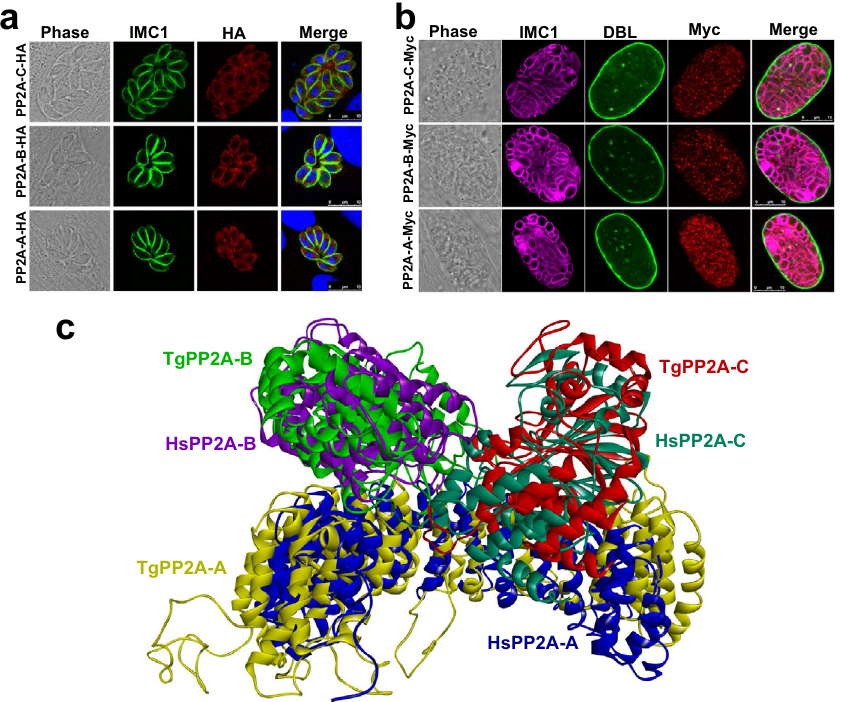
Fig. 1 | Characterization of PP2A holoenzyme of Toxoplasma gondii . a Indirect immuno fl uorescence of T. gondii RH tachyzoites expressing PP2A-C-6HA, PP2A-B- 6HAandPP2A-A-6HAunderthecontroloftheirendogenouspromoters.Cellswere fi xed at 24h post infection and stained with anti-IMC1 (green) antibody, anti-HA (red) antibody, and Hoechst DNA-speci fi c dye (blue). Scale bar, 10 µ m. b Indirect immuno fl uorescence of Pru bradyzoites expressing PP2A-C-6myc, PP2A-B-6myc andPP2A-A-6mycunderthecontroloftheirendogenouspromoters.Parasiteswere grown in HFF cells under bradyzoite-inducing alkaline conditions for 7 days and